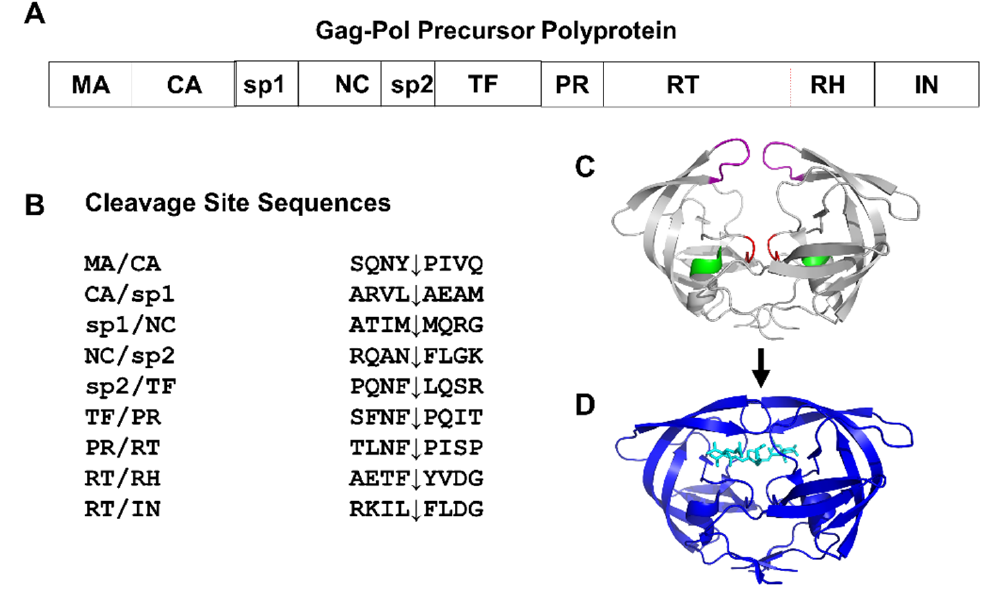
Figure 1. ( A ) The HIV-1 Gag-Pol polyprotein precursor is processed by PR during maturation to release individual structural proteins MA, CA, and NC, and enzymes PR, RT, and IN. ( B ) PR hydrolyzes the peptide bond, indicated by an arrow in the listed cleavage site sequences of Gag-Pol. ( C ) The dimer of mature PR (grey ribbons) exists in an open conformation in the absence of substrate or inhibitor. The conserved catalytic triplet of residues Asp-Thr-Gly is shown in red, the conserved triplet of Gly-Arg-Asn in the alpha helix is in green, and the Gly-rich ends of the flexible flaps are in purple. ( D ) The PR dimer (blue ribbons) bound to the peptide analog of the sp1/NC cleavage site (cyan sticks) has closed conformation flaps.